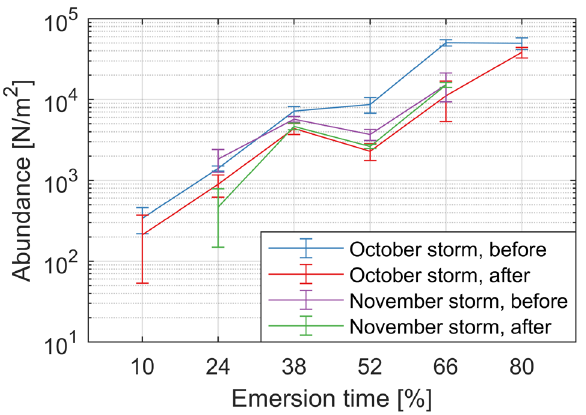
2 ) across six stations equally